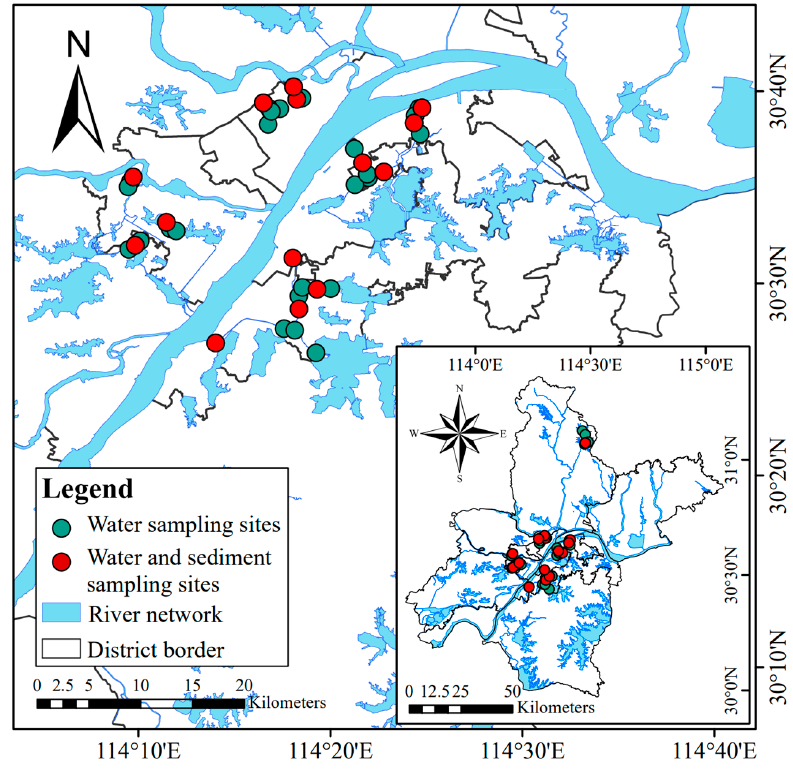
Figure 1. Location map of the study area, and the water and sediment sampling sites.